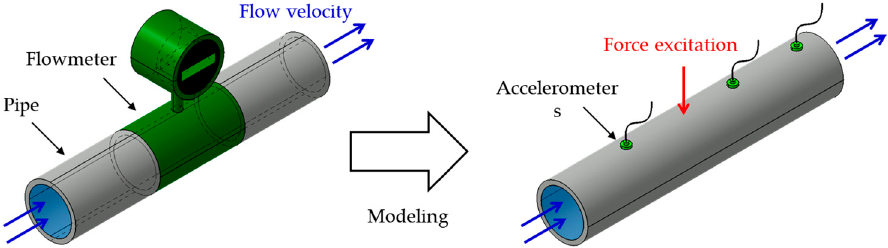
Figure 1. Alternative method for measurement of flow velocity of pipe by using force excitation and accelerometer signals.